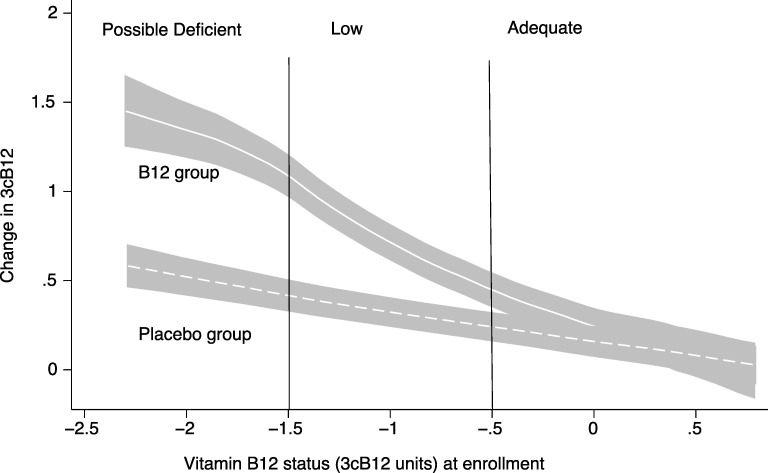
The association between vitamin B12 status at baseline and change in vitamin B12 status from baseline to end study by randomized group.The y-axis is the change in 3cB12 from baseline to end study, and the x-axis is the baseline 3cB12 value. The regression lines were generated by a kernel-weighted local polynomial regression with the change in 3cB12 as the dependent variable and 3cB12 at baseline as the independent variable. The shaded areas represent the 95% CI of the regression lines. The profiles were generated separately for the 2 intervention groups, and the distance between the 2 regression lines represents the effect of the vitamin B12 supplementation. The 3cB12 is a function of the plasma concentrations of cobalamin, tHcy, and MMA. CI, 95% confidence interval; MMA, methylmalonic acid; tHcy, total Homocysteine.